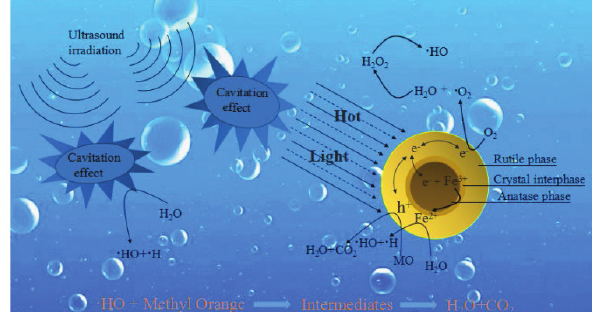
Figure 10: A schematic mechanism for the nanocatalysis of MO dye over Fe-doped TiO 2 nanoparticles (e - : negative electron, h + : positive hole, MO: Methyl Orange)